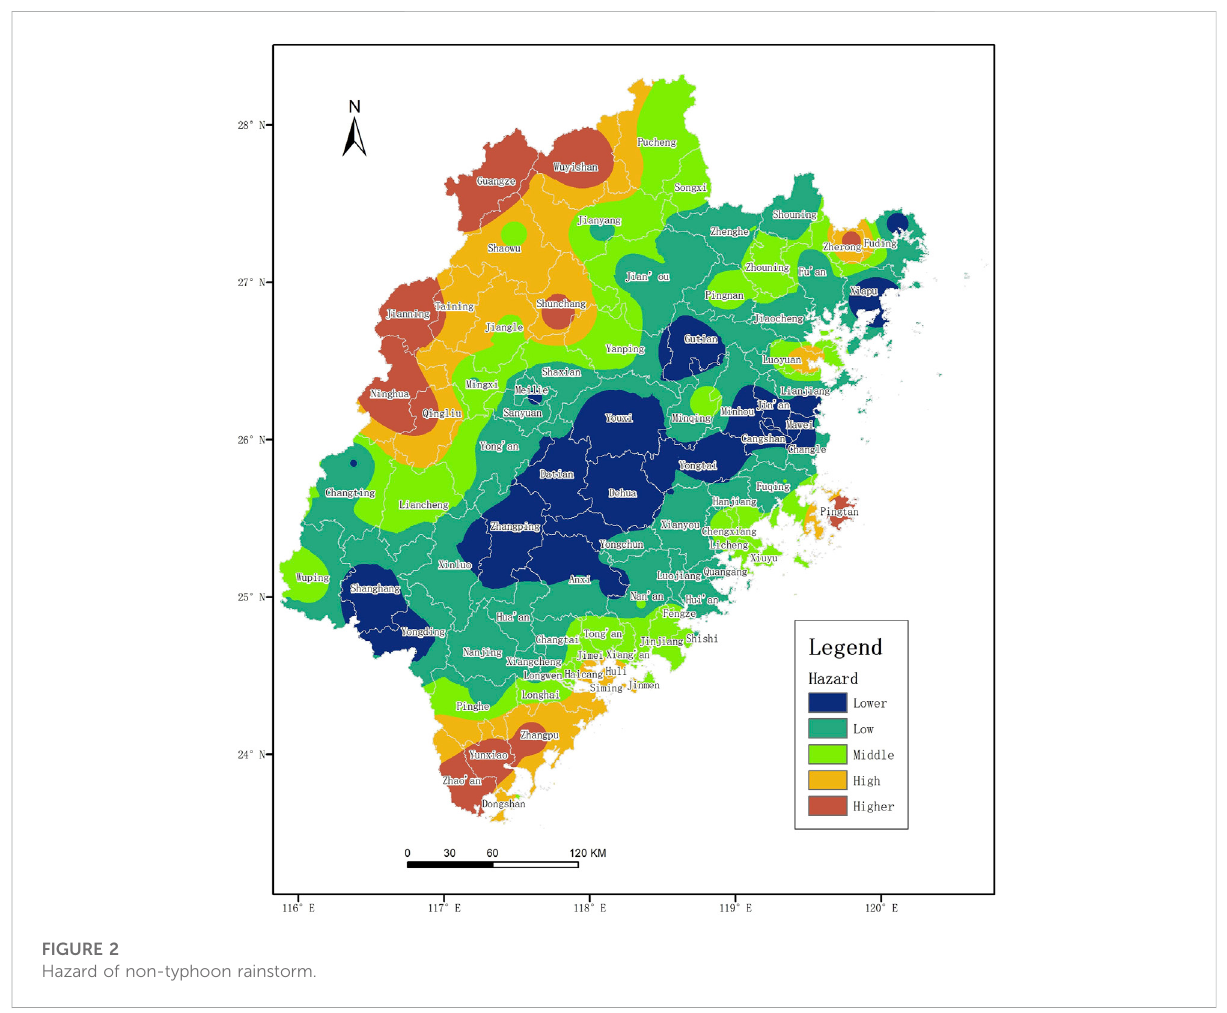
FIGURE 2 Hazard of non-typhoon rainstorm.